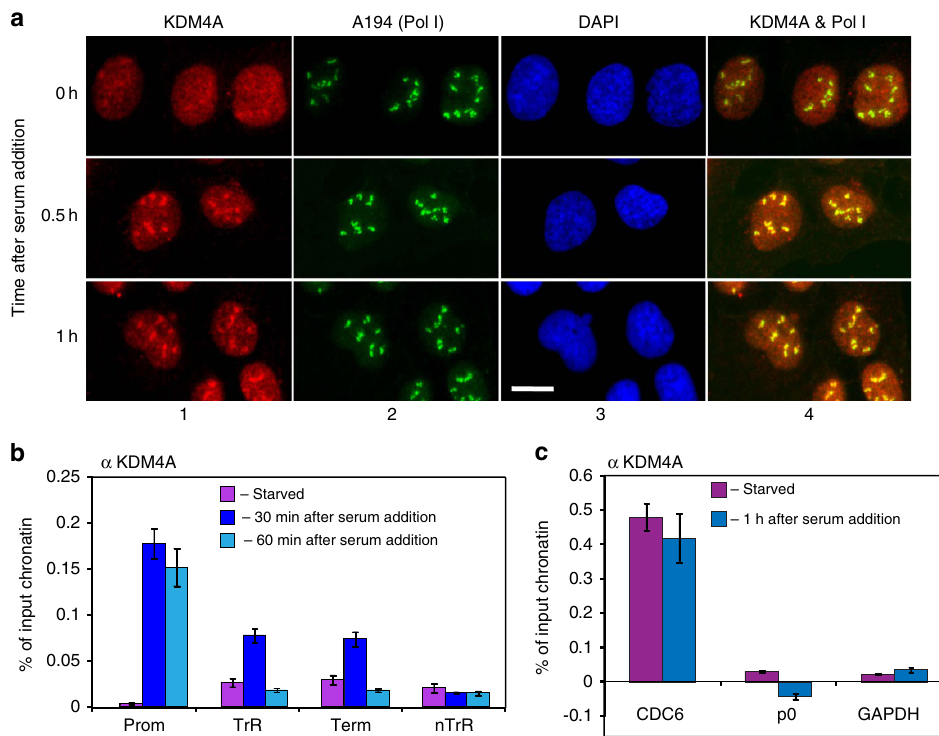
Figure 4 | KDM4A localization and association with rDNA is controlled by serum. ( a ). U2OS cells were serum starved for 24h ( t ¼ 0) and refed with serum. Cells were fixed at 30 and 60min following serum addition, and analysed by indirect immunofluorescence using antibodies specific to human KDM4A (Ab1 Bethyl Lab, panels 1) and human Pol-I largest subunit A194 (panels 2); nuclear DNA was stained by DAPI (panels 3). Merged images are shown (panel 4). Scale bar, 5 m M. ( b ) ChIP assays were performed using antibodies specific to human KDM4A (Ab1, Bethyl Lab) and chromatin isolated from starved and starved–refed cells (30 and 60min after serum addition) and analysed as in Fig. 1c to determine KDM4A binding to rDNA promoter (Pr), transcribed region (TrR) or non-transcribed region (nTrR). The value of each bar represents the difference between the signals from the specific antibody and from the negative control (an appropriate IgG) expressed as % from total chromatin input (see Supplementary Fig. 3b for raw data). Standard deviations from three independent experiments are shown; n ¼ 3. ( c ) ChIP assays were performed using antibodies specific to human KDM4A as in b and chromatin immunoprecipitated from starved and starved–refed cells (60min after serum addition) were analysed by qPCR for the presence either CDC6 or P0 or GAPDH promoters representing a positive and negative controls of the anti-KDM4A ChIP, respectively. The value of each bar represents the difference between the signals from the specific antibody and from the negative control (an appropriate IgG) expressed as % from total chromatin input (see Supplementary Fig. 3c for raw data). Standard deviations from three independent experiments are shown; n ¼